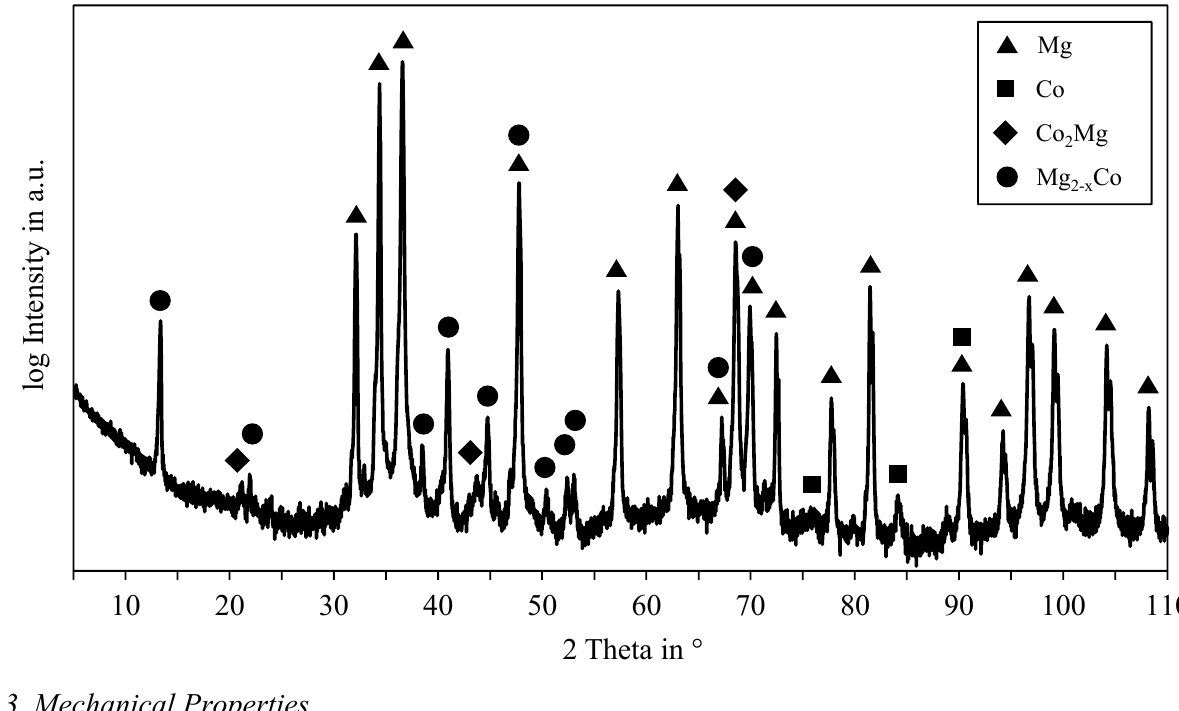
Figure 5. Diffraction pattern of the alloy Mg96Co4 in as-cast